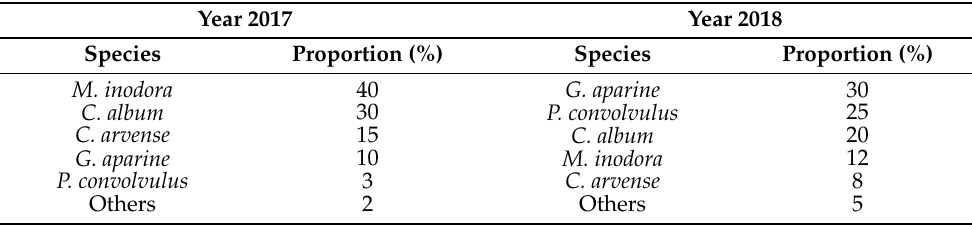
Table 5. The weed composition of the major weed species for the trials of 2017 and 2018 at the research station Ihinger Hof.